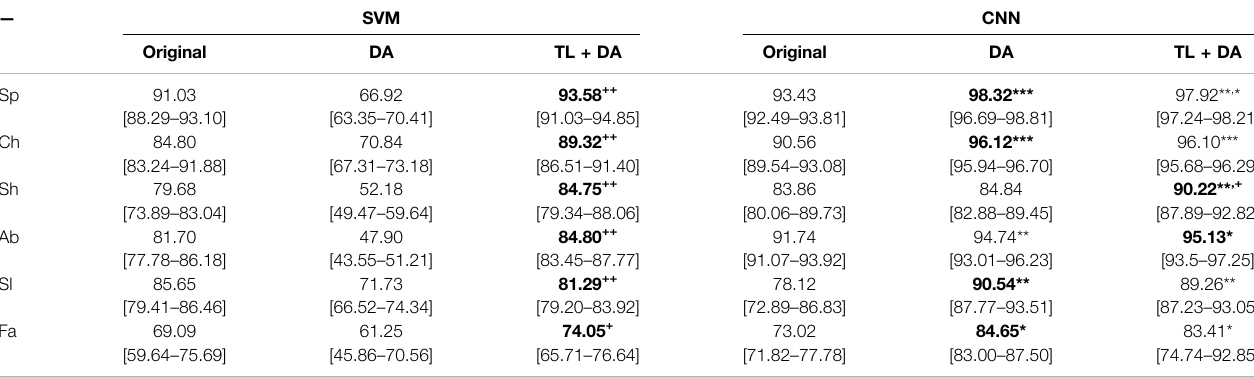
TABLE 2 | Performance of the machine learning models for each of the sub-groups of the BS dataset. The results are presented as median AUC (25th percentile — 75th percentile)(%).Ontheleftside,theresultsfortheSVM.Ontherightside,theresultsfortheCNN.Thebestresults(i.e.,higherAUC)foreachmodelforeachbreathingtype are in